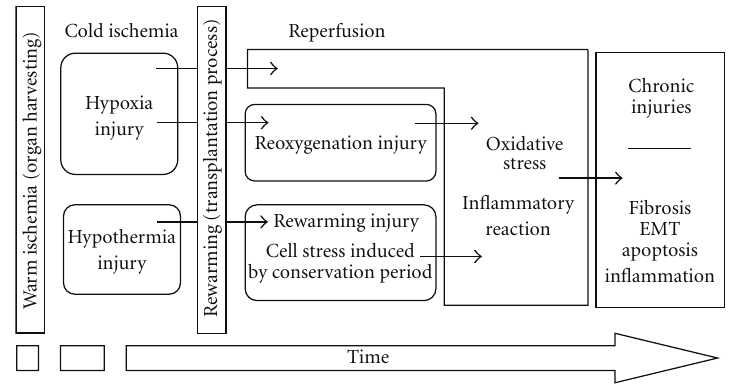
Figure 3: Major processes induced by ischemia-reperfusion injury in renal